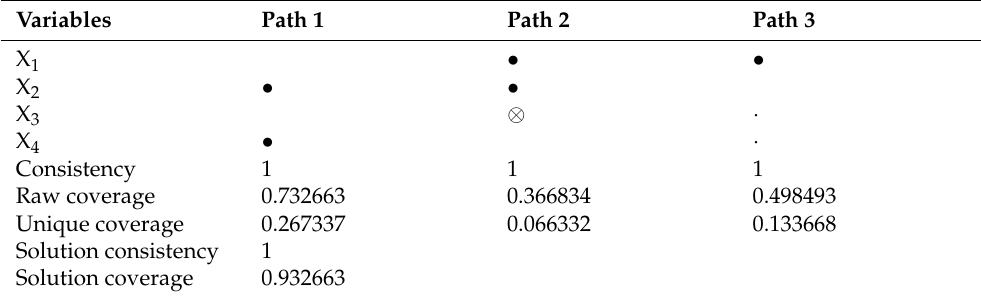
Table 7. Combination configuration of influencing factors for the medium–high intensity collaborative governance